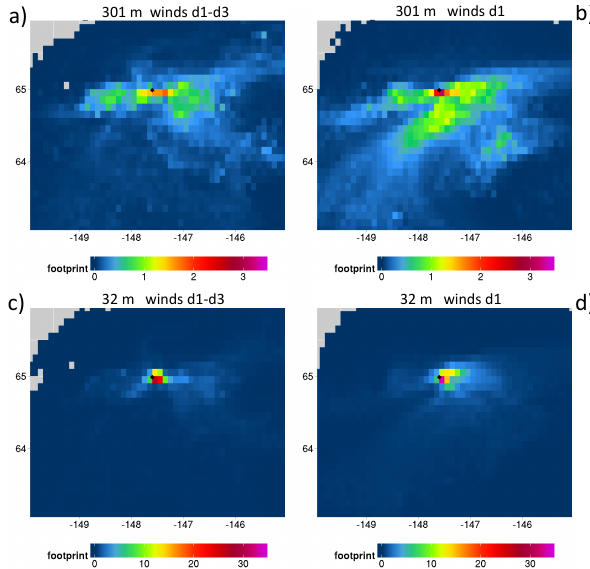
Figure 16. Aggregate of all STILT footprints (units are ppmv / (micromolem − 2 s − 1 )) on 0.1 ◦ grid for 120 hourly recep- tors placed at the CARVE tower during the period 00:00UTC 13 September to 23:00UTC 17 September 2012. Panels (a) and (b) are for receptors at 301m, while panels (c) and (d) are for receptors at 32m. Winds from domains 1, 2, and 3 of one-way nested WRF v3.5.1 runs are used in (a) and (c) ; winds only from domain 1 (the outermost domain) are used in (b) and (d) . The black circle near the center of the grid marks the tower location. Note the change in color scale between the top and bottom